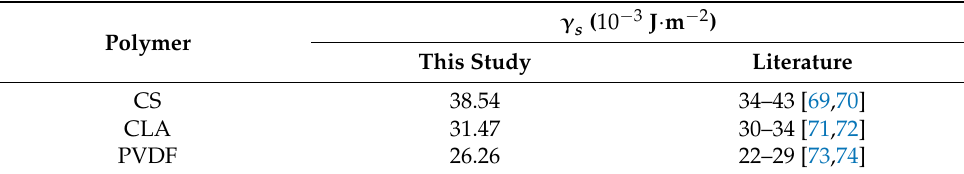
Table 6. Surface energy of CS, CLA and PVDF polymer matrixes provided by this study and from literature.